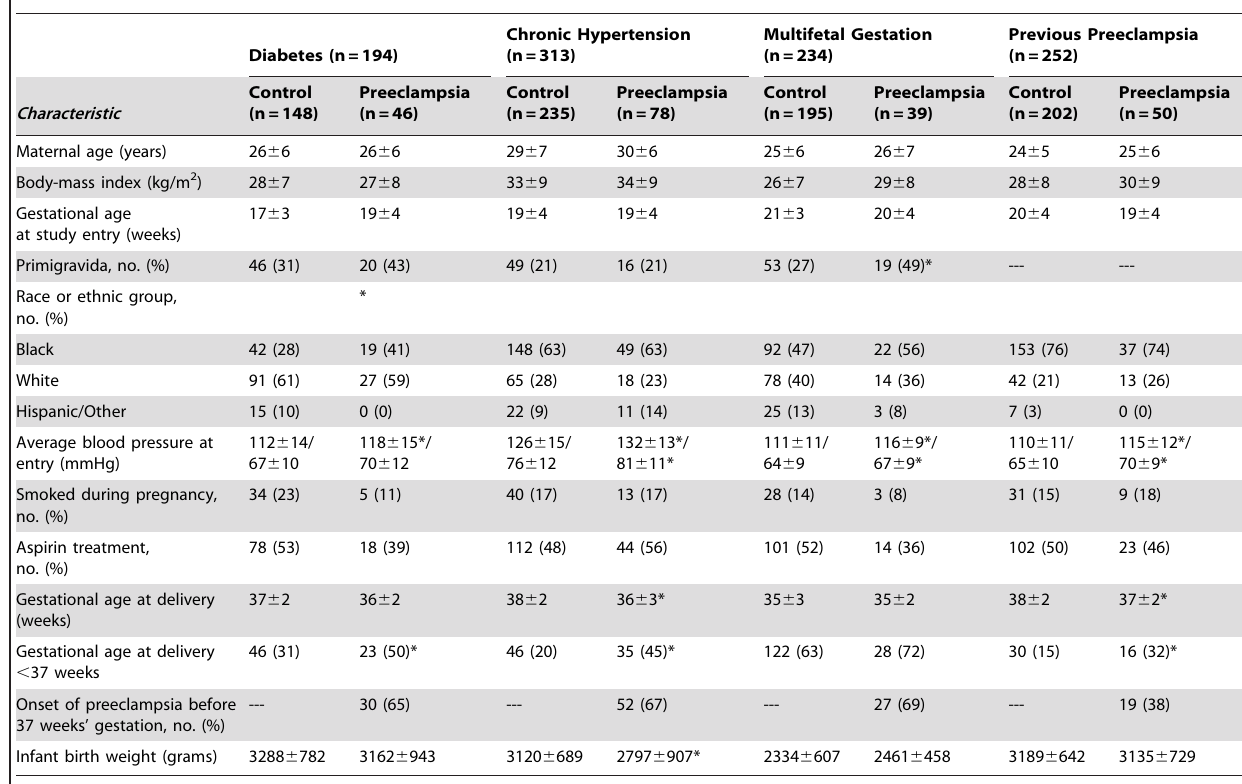
Table 1. Study Subject Information According to High-Risk